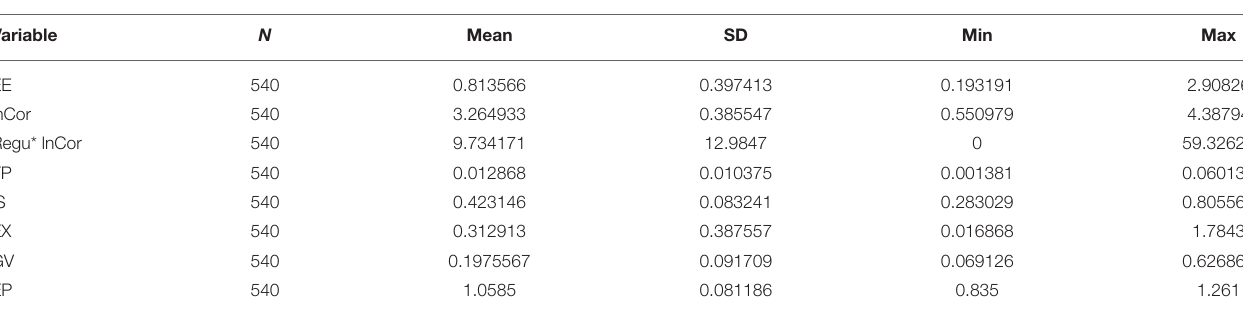
TABLE 5 | Descriptive statistics of